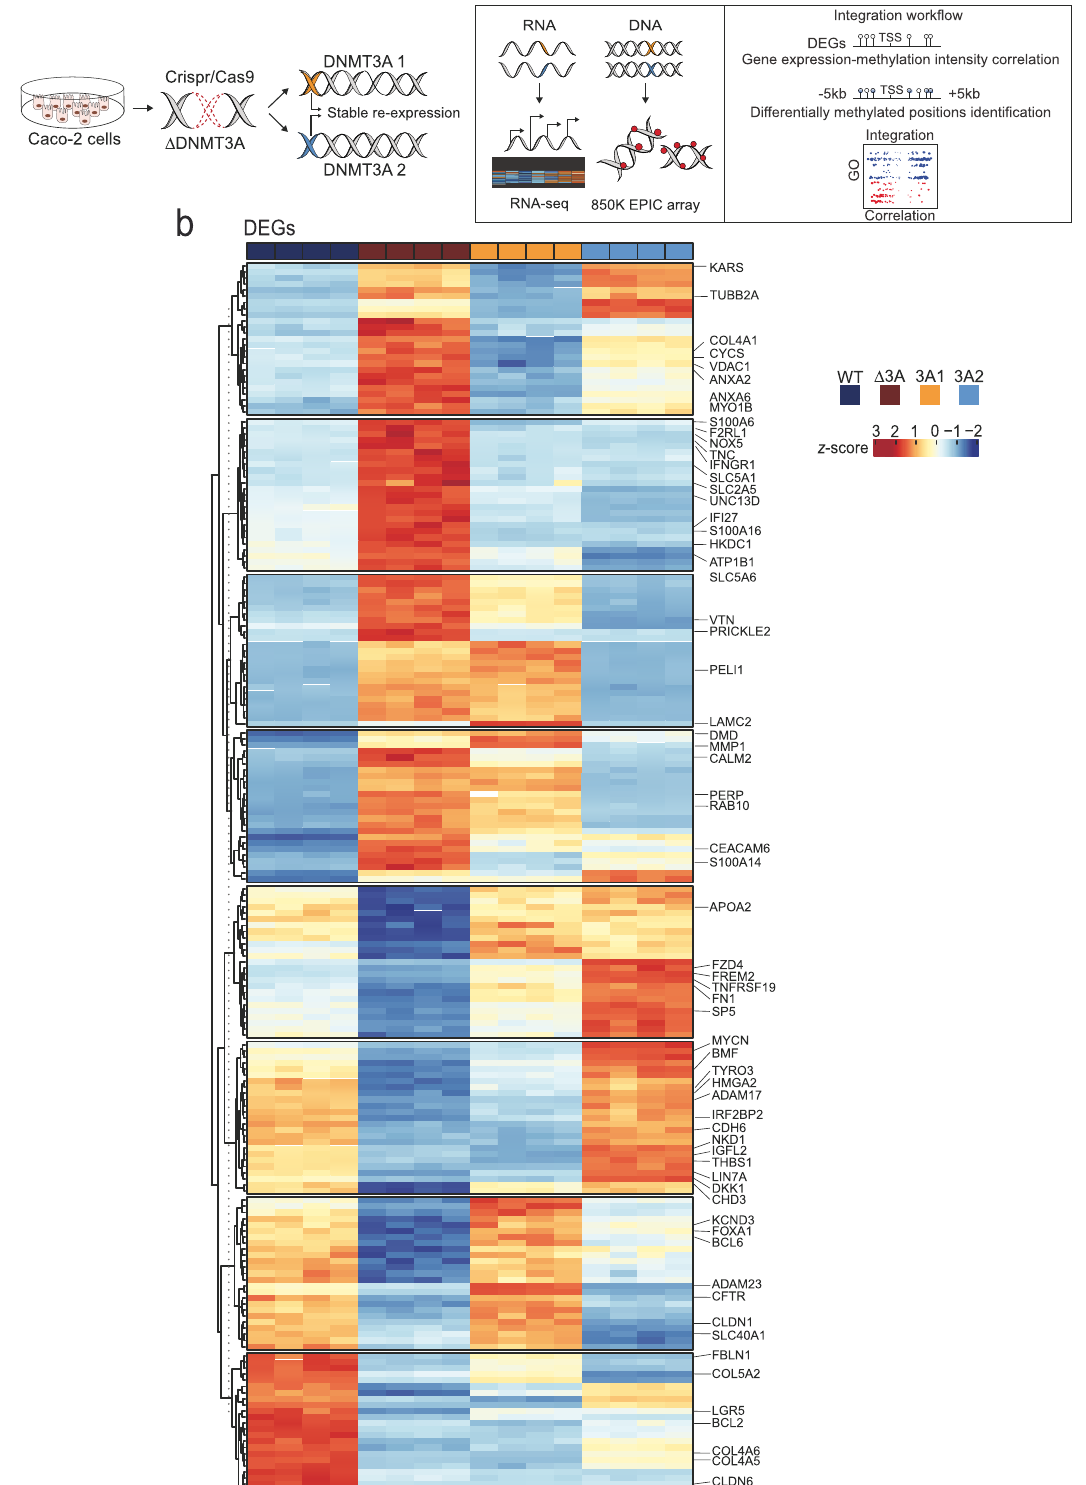
Fig. 2 | Deletion of DNMT3A results in complex mRNA expression changes in Caco-2 cells. a Schematic representation of cell lines generation and data analysis work fl ow. Graphical elements modi fi ed from ref. 17. b Heatmaps of